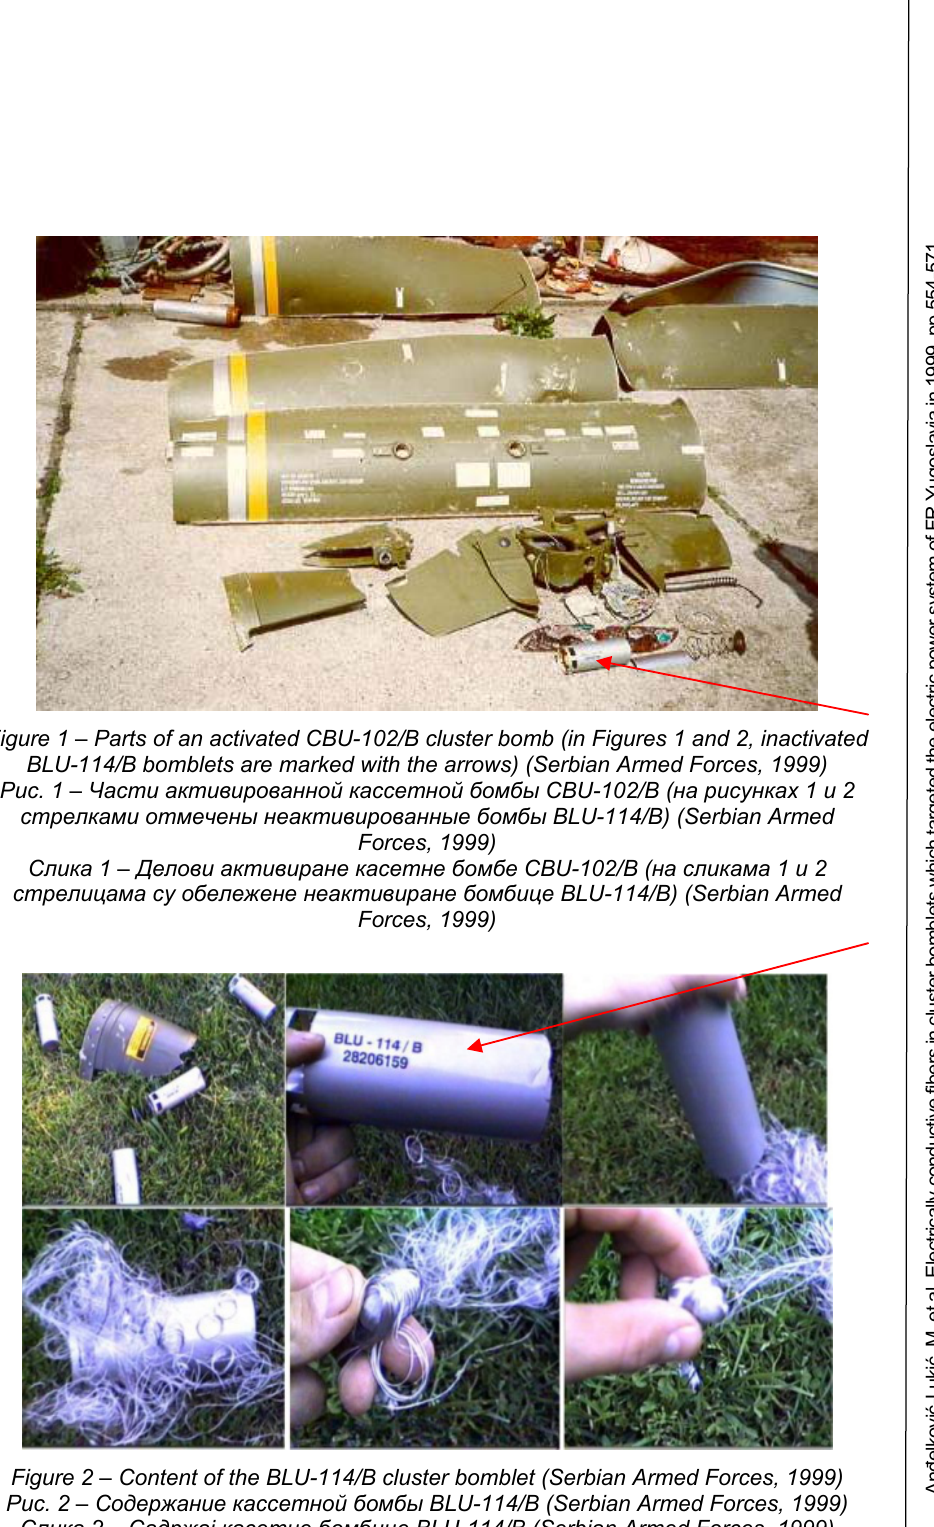
Figure 2 – Content of the BLU-114/B cluster bomblet (Serbian Armed Forces, 1999) Рис . 2 – Содержание кассетной бомбы BLU-114/B (Serbian Armed Forces, 1999) Слика 2 – Садржај касетне бомбице BLU-114/B (Serbian Armed Forces,